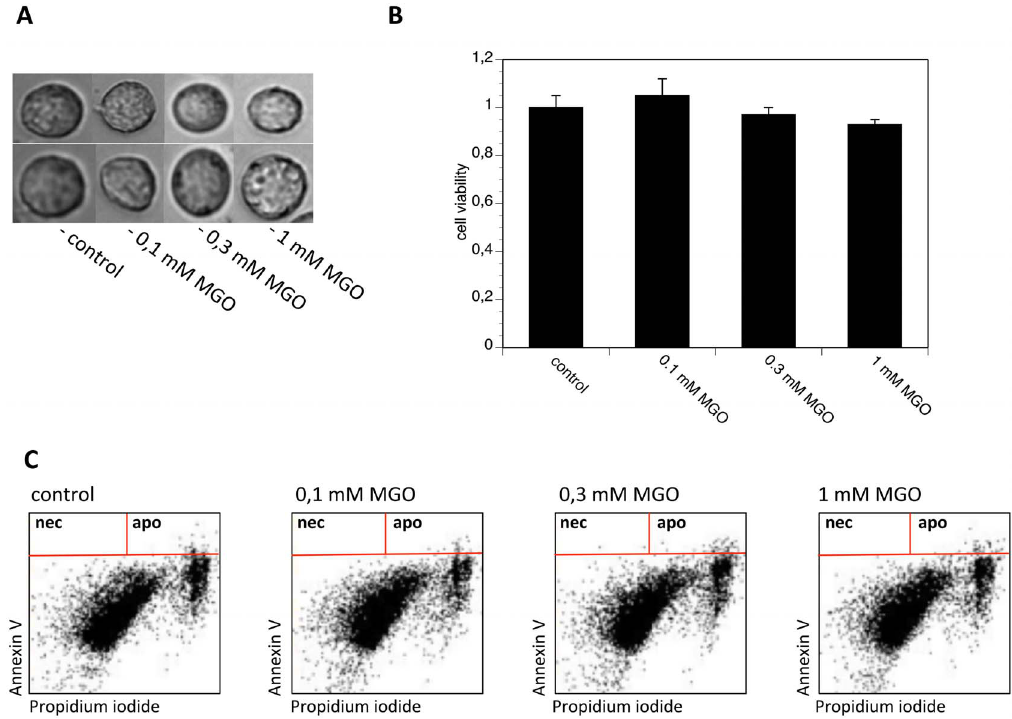
Figure 6. Cell viability after MGO treatment. PC12 cells were incubated with PBS, 0.1 mM MGO, 0.3 mM MGO or 1 mM MGO for 4 hours. A. Micrographs of typical PC12 cells. B. Tryphan blue staining of PC12 cells. Bars represent three independent experiments carried out in quadruplicates. Cell viability of cells cultured in the presence of PBS (=control) was set to 1 and cell viability expressed in relation to the control. C. FACS analysis of PC12 cells stained with annexin V and propidium iodide.